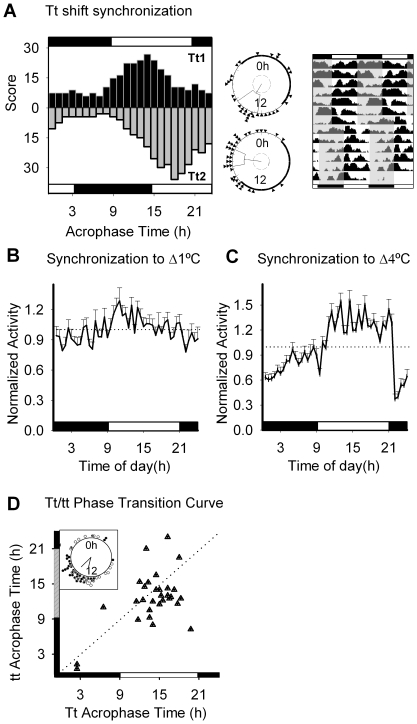
Temperature synchronization.A) Acrophase histogram of nematodes entrained to a high (17°C) - low (16°C) temperature cycle, before and after a 6 h shift of the thermal cycle. The dark-white bar corresponds to cycles of low and high temperature, respectively. The middle panel shows the Rayleigh analysis for both situations: Tt1(17°C from 0900 h to 2100 h, 16°C from 2100 h to 0900 h; p<0.05 n = 32) and Tt2(17°C from 1500 h to 0300 h, 16°C from 0300 h to 1500 h; p<0.05 n = 38). The right actogram corresponds to average activity of the population. Gray shaded areas represent the phase of high temperature of the daily cycle. B) Average daily activity plot corresponding to 3 days of data from 20 nematodes synchronized to a 17∶16°C. There was a significant variation between activity values during the high and low temperature phases (Maximum value = 1.28±0.13 (1100 h) ; Minimum value  = 0.78±0.07 (2200 h), p<0.03, ANOVA). C) Average daily activity plot corresponding to 3 days of data from 20 nematodes synchronized to a 20∶16°C cycle. There was a significant variation between activity values during the high and low temperature phases (Maximum value = 1.55±0.12 (1400 h), Minimum value  = 0.37±0.06 (2200 h); p<0.0001, ANOVA). D) Comparison of locomotor activity acrophases between Tt (20°C∶16°C) and the initial days after release into constant darkness (DD) and constant temperature conditions (16°C). Inset: Rayleigh analysis of locomotor activity acrophase under Tt and tt cycles (Tt (black circles): r = 0.7 phi = −2.4 (14.8 h) n = 35; tt (white circles): r = 0.5 phi = −2.9 (12.9 h) n = 31).